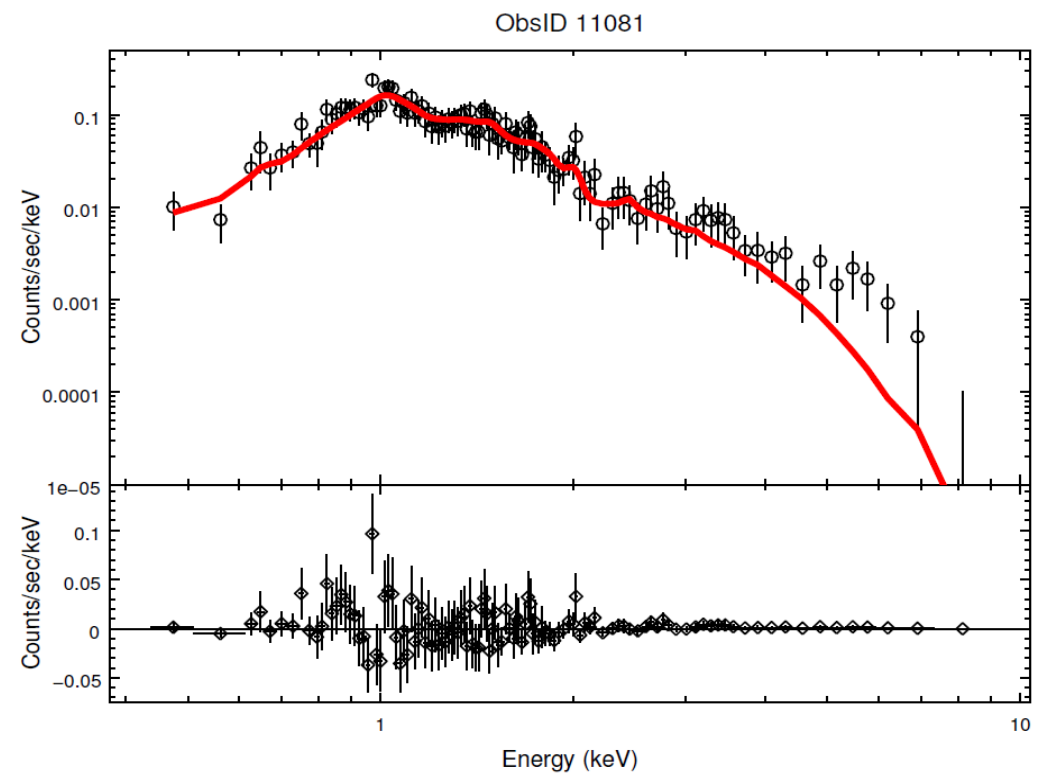
Figure 7. TV Cas Spectrum from Chandra Observation ID 11081.